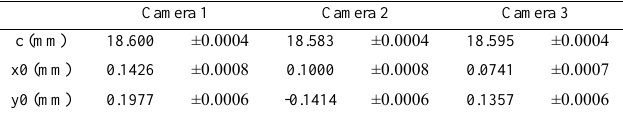
Table 1: Camera calibration